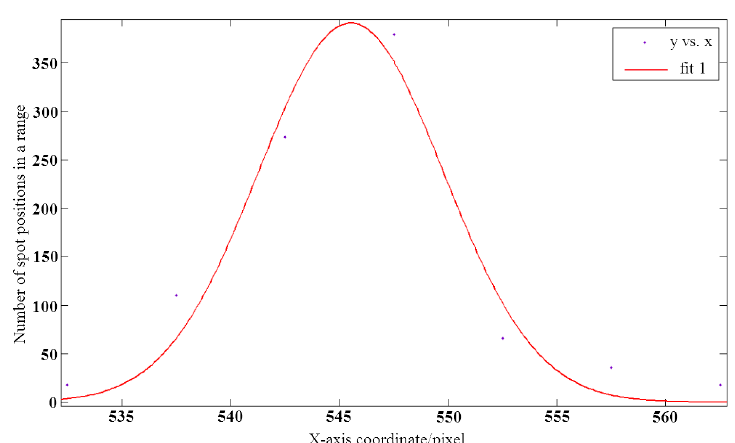
Figure 18. Position probability distribution.